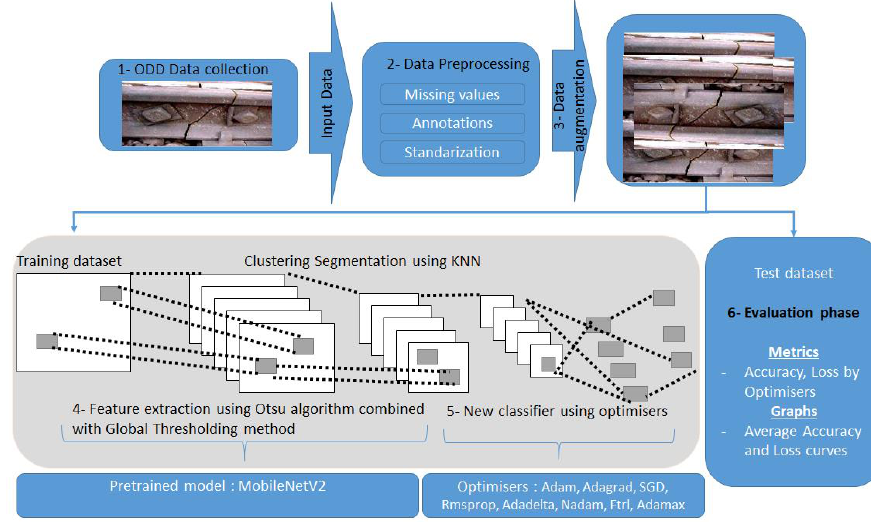
Fig. 5. General schema for experimental studies